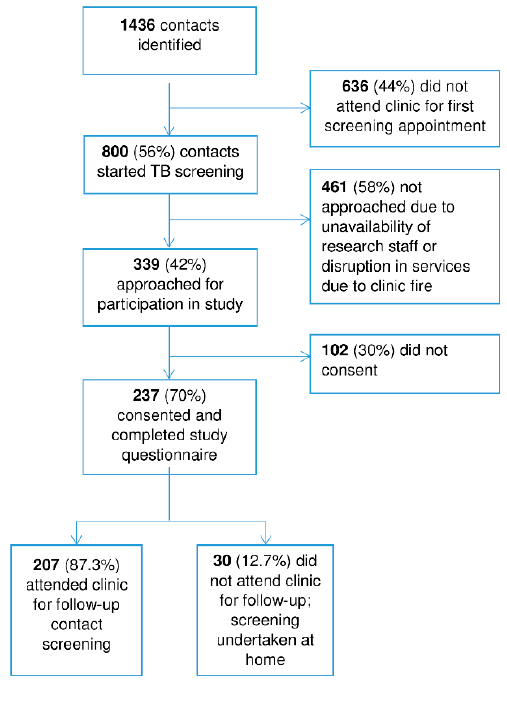
Figure 1. Study diagram.